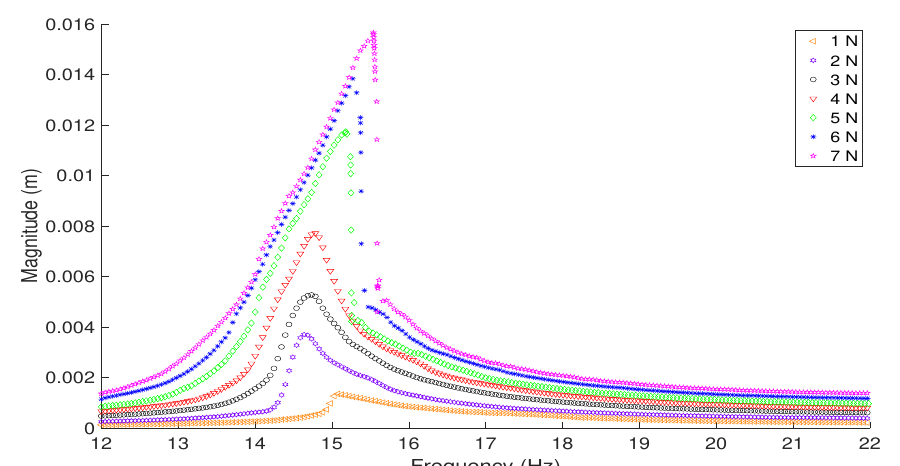
Figure A1. Response of the structure under increasing forces, sweeping upwards through frequencies surrounding the first resonance frequency.